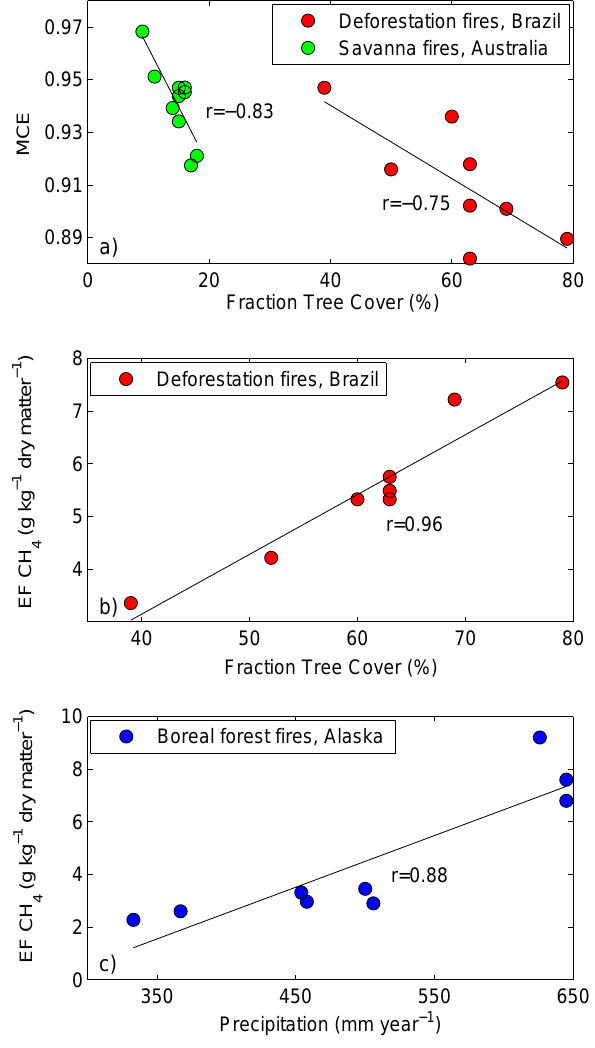
Fig. 4. Relations between environmental variables and EFs or MCE for selected regions. (a) FTC and MCE for savanna measurements in Australia (Hurst et al., 1994; Shirai et al., 2003) and tropi- cal deforestation measurements in Brazil (Yokelson et al., 2007), (b) FTC and CH 4 EF for tropical deforestation measurements in Brazil (Yokelson et al., 2007), and (c) precipitation and CH 4 EF for extratropical forest measurements in Alaska (Laursen et al., 1992; Goode et al., 2000; Wofsy et al., 1992; Nance et al., 1993).